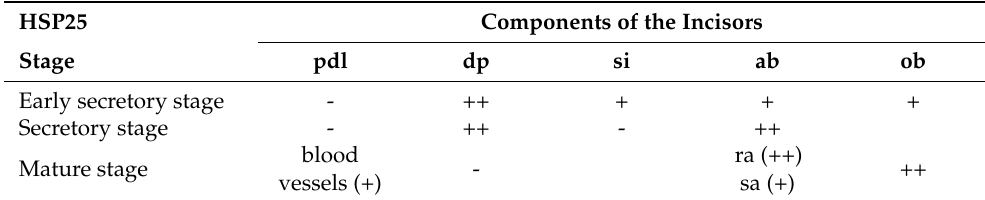
Table 3. Expression of heat shock protein 25 (HSP25) in the incisors of postnatal (PN) day 30 rats.